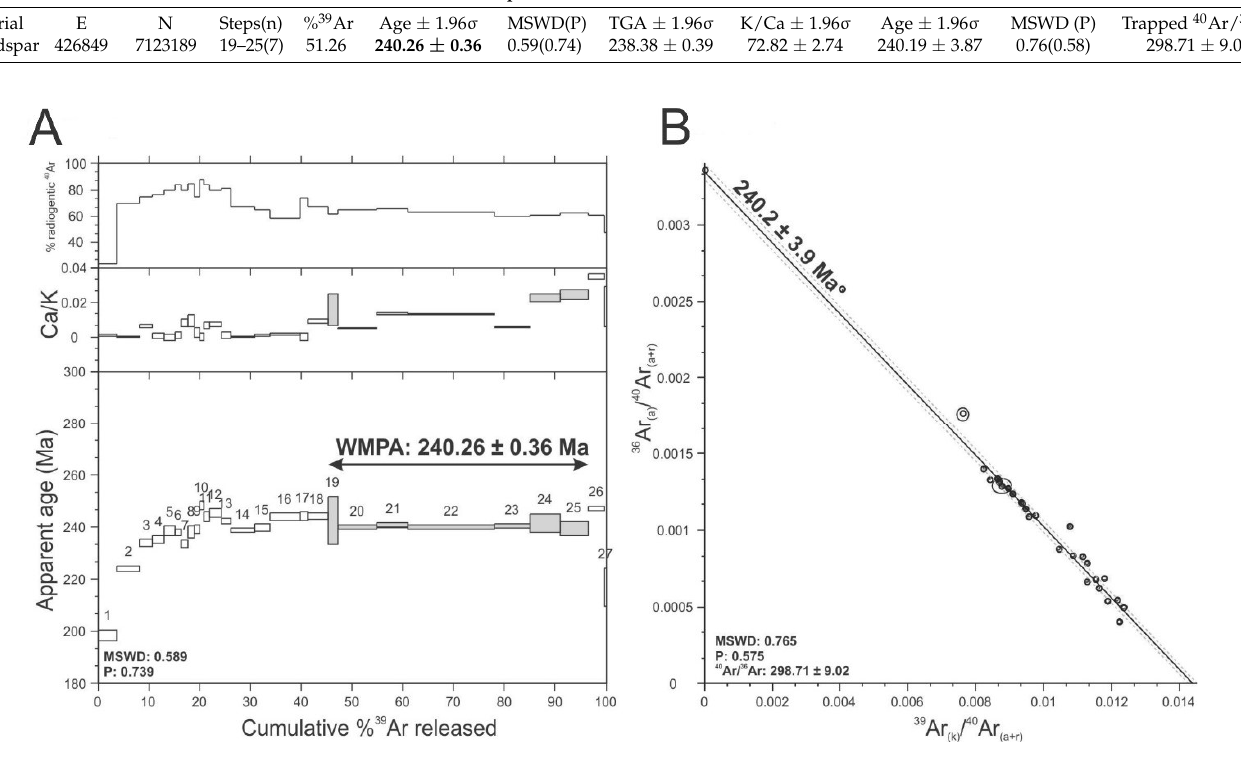
Figure 7. 40 Ar/ 39 Ar degassing spectra and inverse isochron results. See text for denotations. Uncertainties are reported at the 1.96sd level (95% confidence).